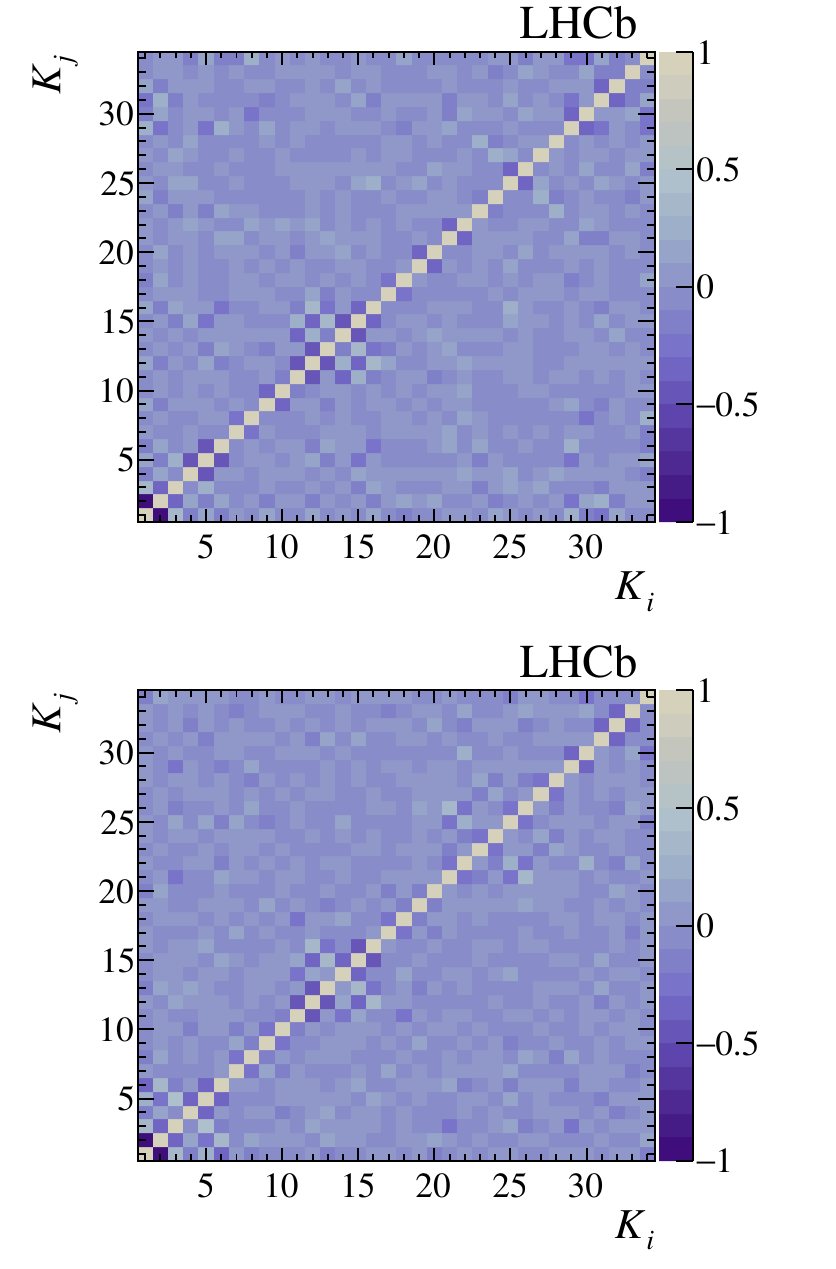
Figure 5 . Correlation coe(cid:14)cients between the observables (top) in the Run 1 data and (bottom) in the Run 2 data. The correlations are estimated using bootstrapped